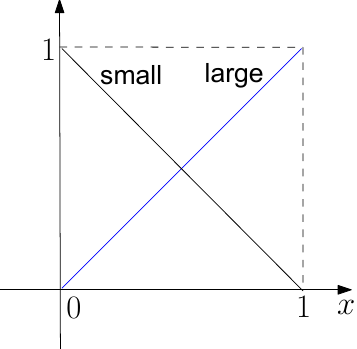
Figure 7. Membership functions for a variable associated with two fuzzy numbers.